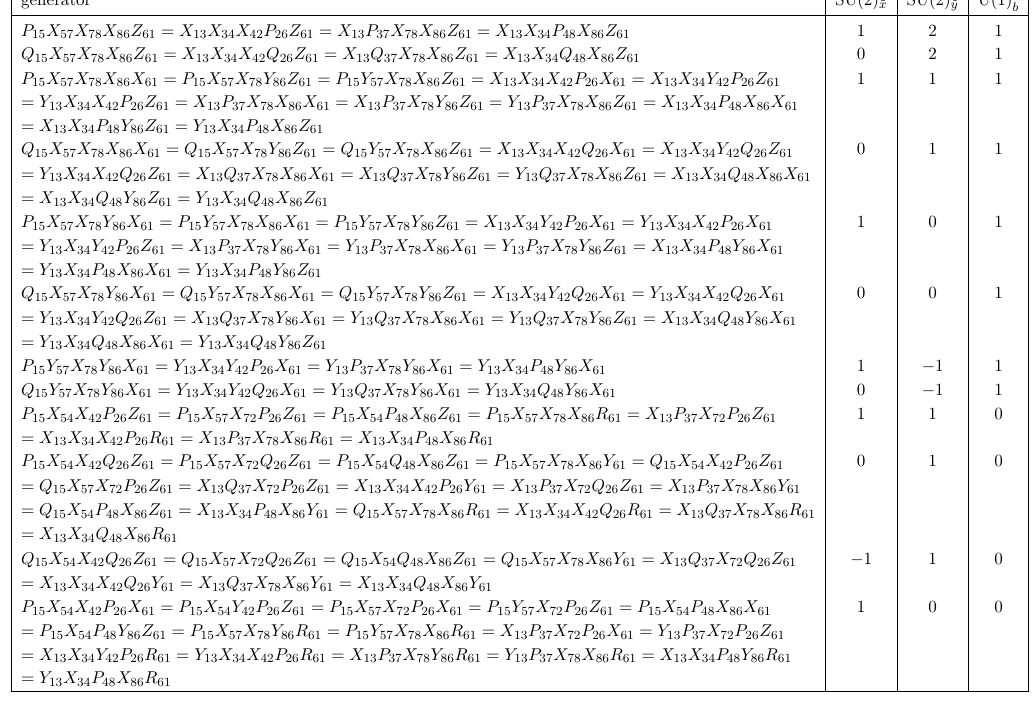
Table 25 . The generators in terms of bifundamental chiral fields for Model 6 (Part 1)